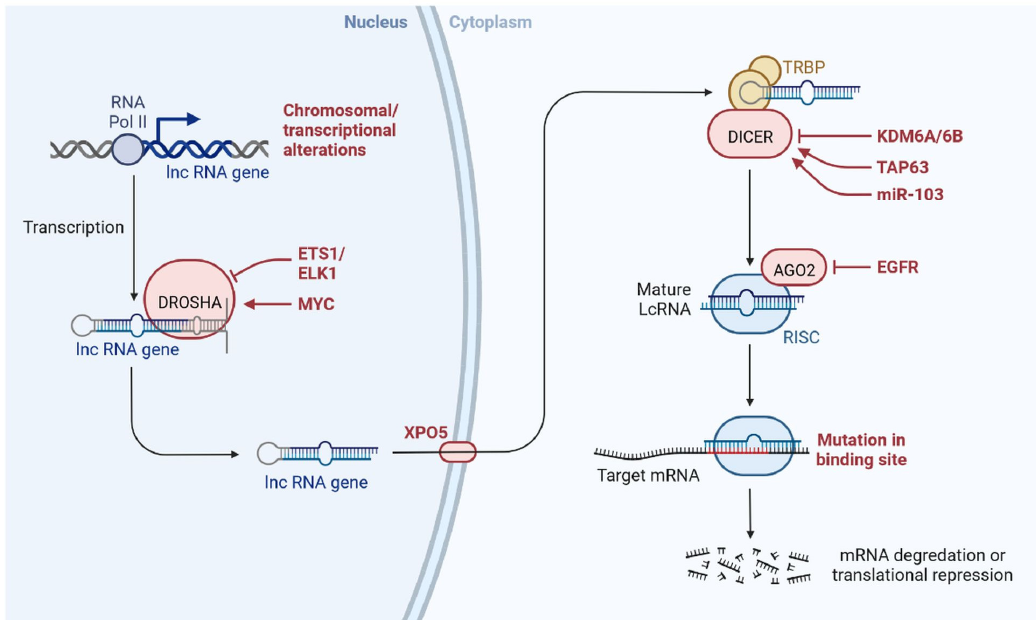
Figure 5. lncRNAs are involved with the functional repercussions at the cellular and physiological level. RNA-induced silencing complex (RISC): KDM5B (lysine-specific demethylase 5B also known as histone demethylase JARID1B), H3K4me3 (trimethylation of lysine 4 on the histone H3 protein subunit), H3K4me1 (monomethylation of lysine 4 on the histone H3 protein subunit), hsa-miR-448 (also known miRNA448), BRCA1/2 (breast cancer 1/2), pRB (retinoblastoma protein), CAV 1 (caveolin 1), HOXA5 (Homeobox protein Hox-A5), SFN (Stratifin), CH3 (methyl group), and RhoA (Ras homolog gene family, member A).